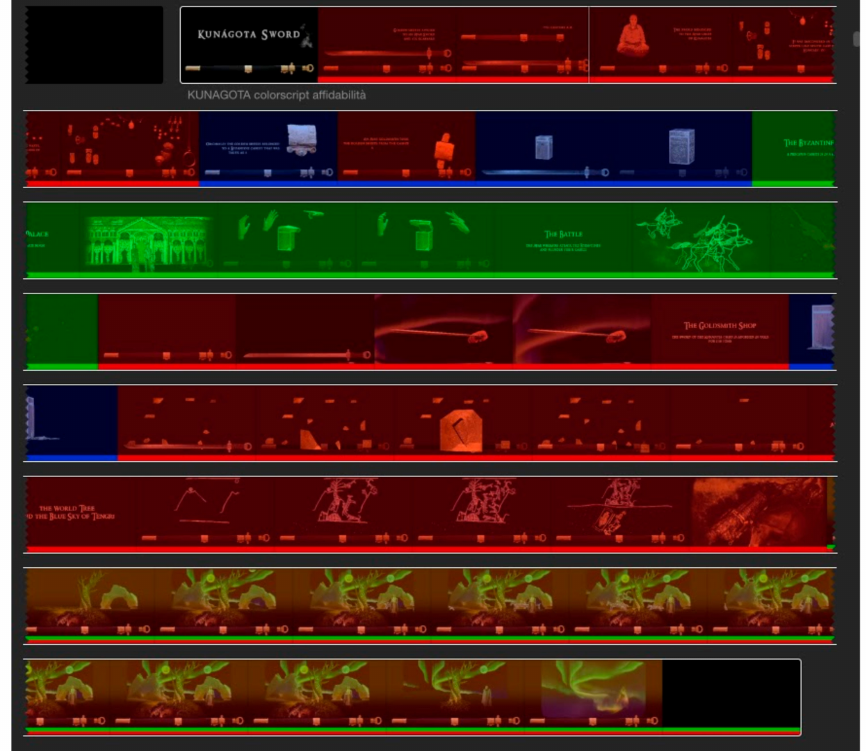
Figure 11. Colorscript of the reliability of the Kunagota Sword story: RED: certain, based on archaeological evidence; BLUE: very probable, based on cultural–contextual evidence; GREEN: evocative, based on historical and cultural